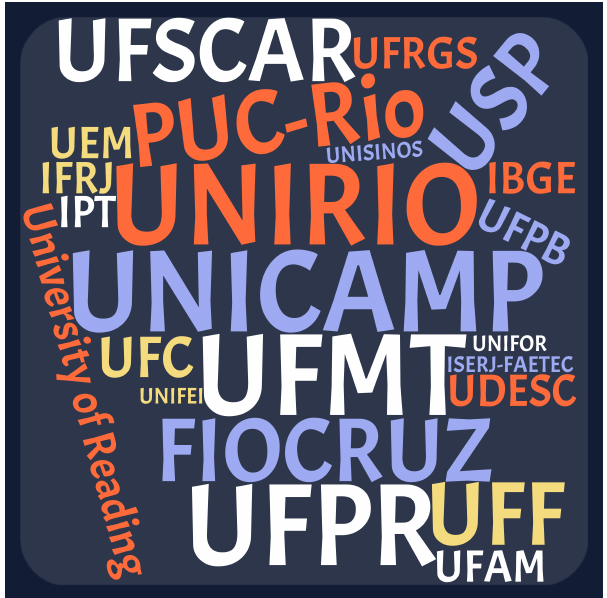
Figure 6. Institutions involved in the selected